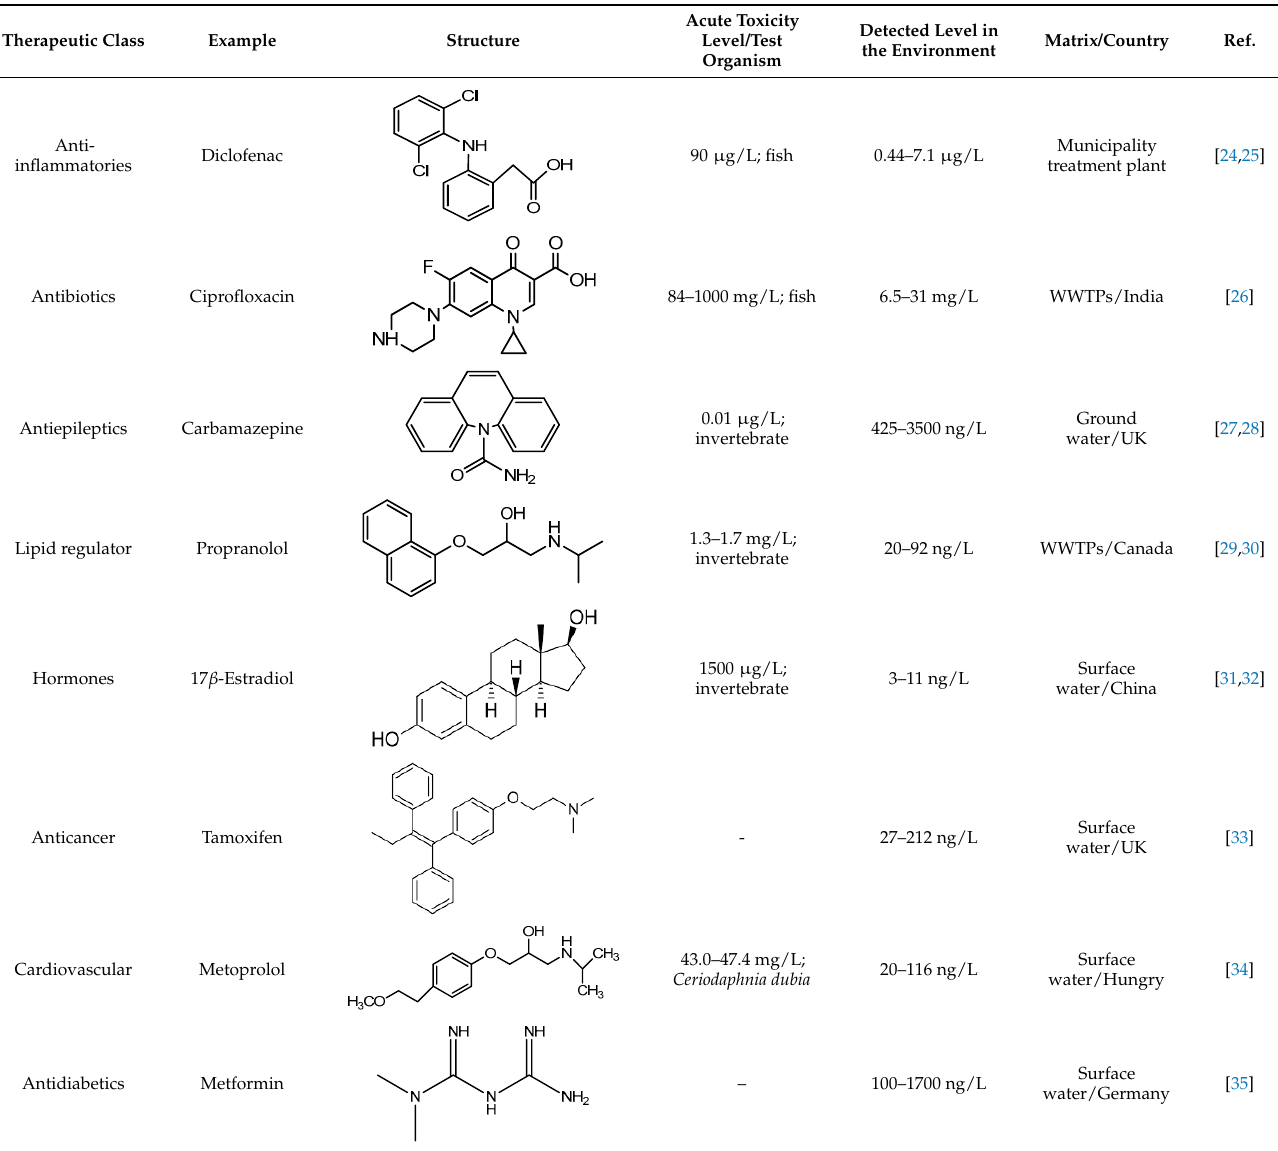
Table 1. Some therapeutic classes of pharmaceuticals, toxicity level and their level of detection in the environment.